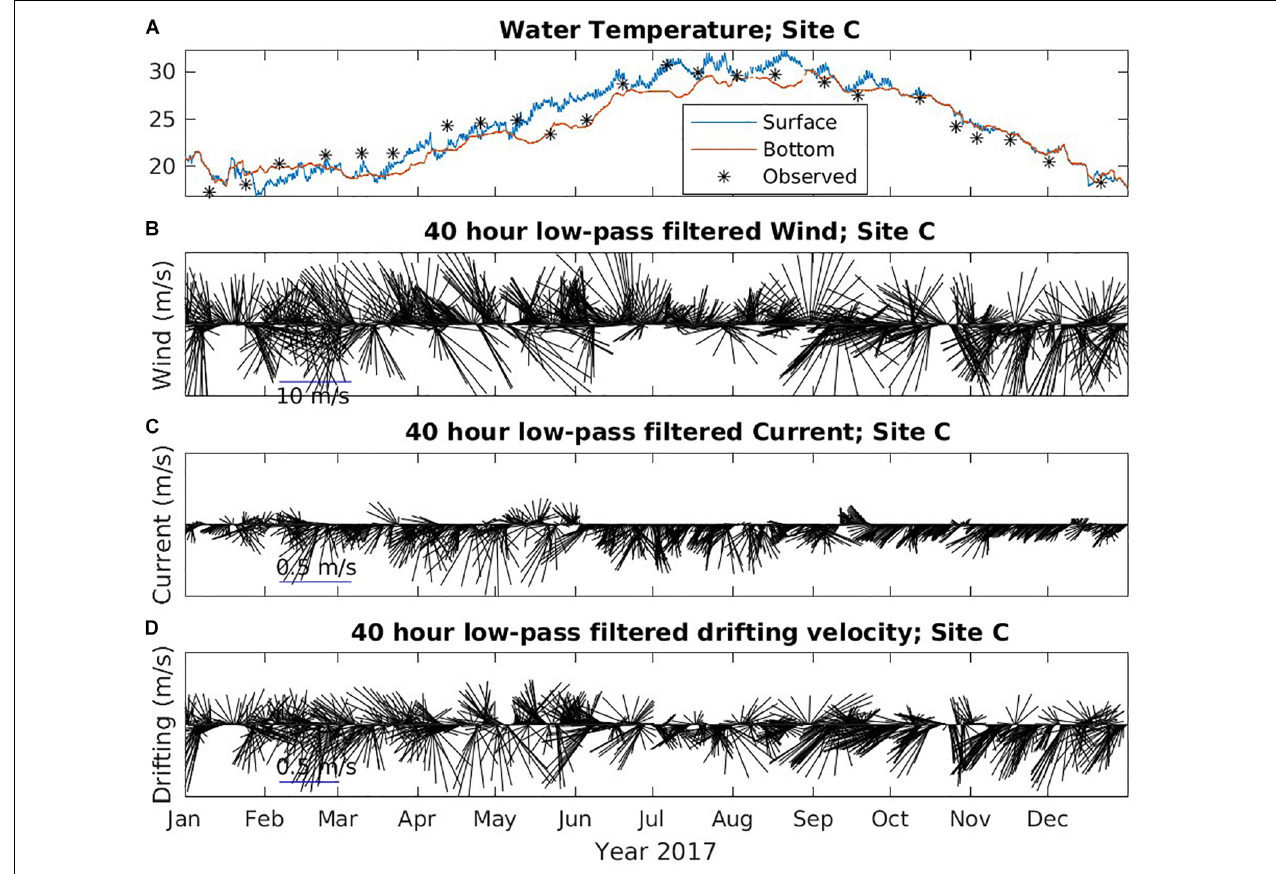
FIGURE 9 | Time series of environmental data at Site C from NGOFS. (A) Water temperature ( ◦ C); (B) Wind vector (m/s); (C) Surface current vector (m/s); and (D) drifting velocity vector (m/s). A 40-h low-pass filter was applied to wind, current and drifting velocity to remove the fluctuations with periods less than 40 h. Vectors pointing “up” indicate northward